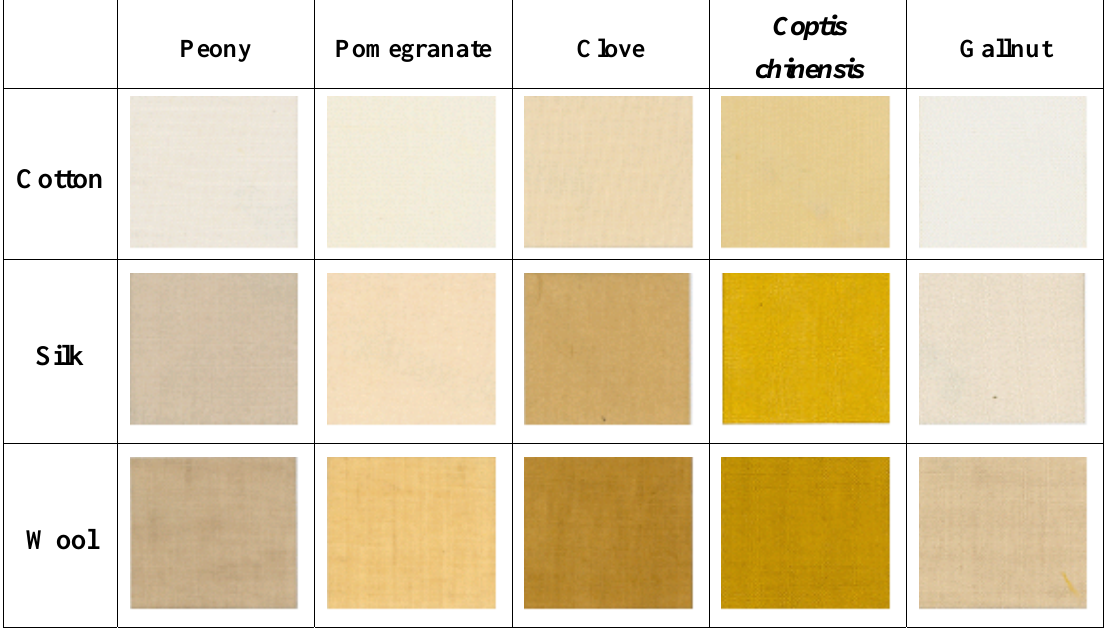
Figure 3. Various colors of dyed fabrics (cotton, silk, and wool fabrics) using peony, pomegranate, clove, Coptis chinensis and